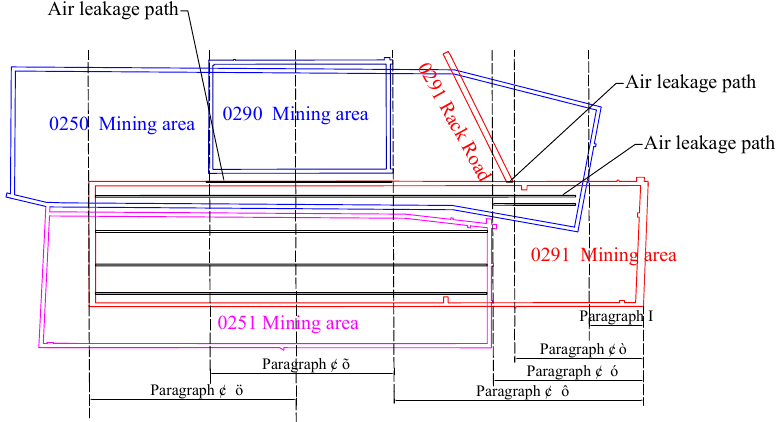
Figure 5. Schematic diagram of the sectioning situation of the mining area. Combined with the actual situation of the mine, the ventilation method is a “U” ven- tilation, and the mining area is divided into a bubble zone and fissure zone, the height is calculated by Formulas (15) and (16) and the physical model of the mining area is estab- lished. The size of the inlet and return air tunnel is 50 m × 3 m × 4 m; the size of the working face is 142 m × 4 m × 4 m; the bubble zone is 142 m wide and 10 m high; the fissure zone is 142 m wide and 40 m high. The grid is divided into a hexahedral grid, with a single grid size of 2 m in the mining area and a single grid size of 1 m in the inlet and return air tunnel and the working face area and the grid of the air leakage path is encrypted and refined to ensure the accuracy of the simulation, as shown in Figure 6.